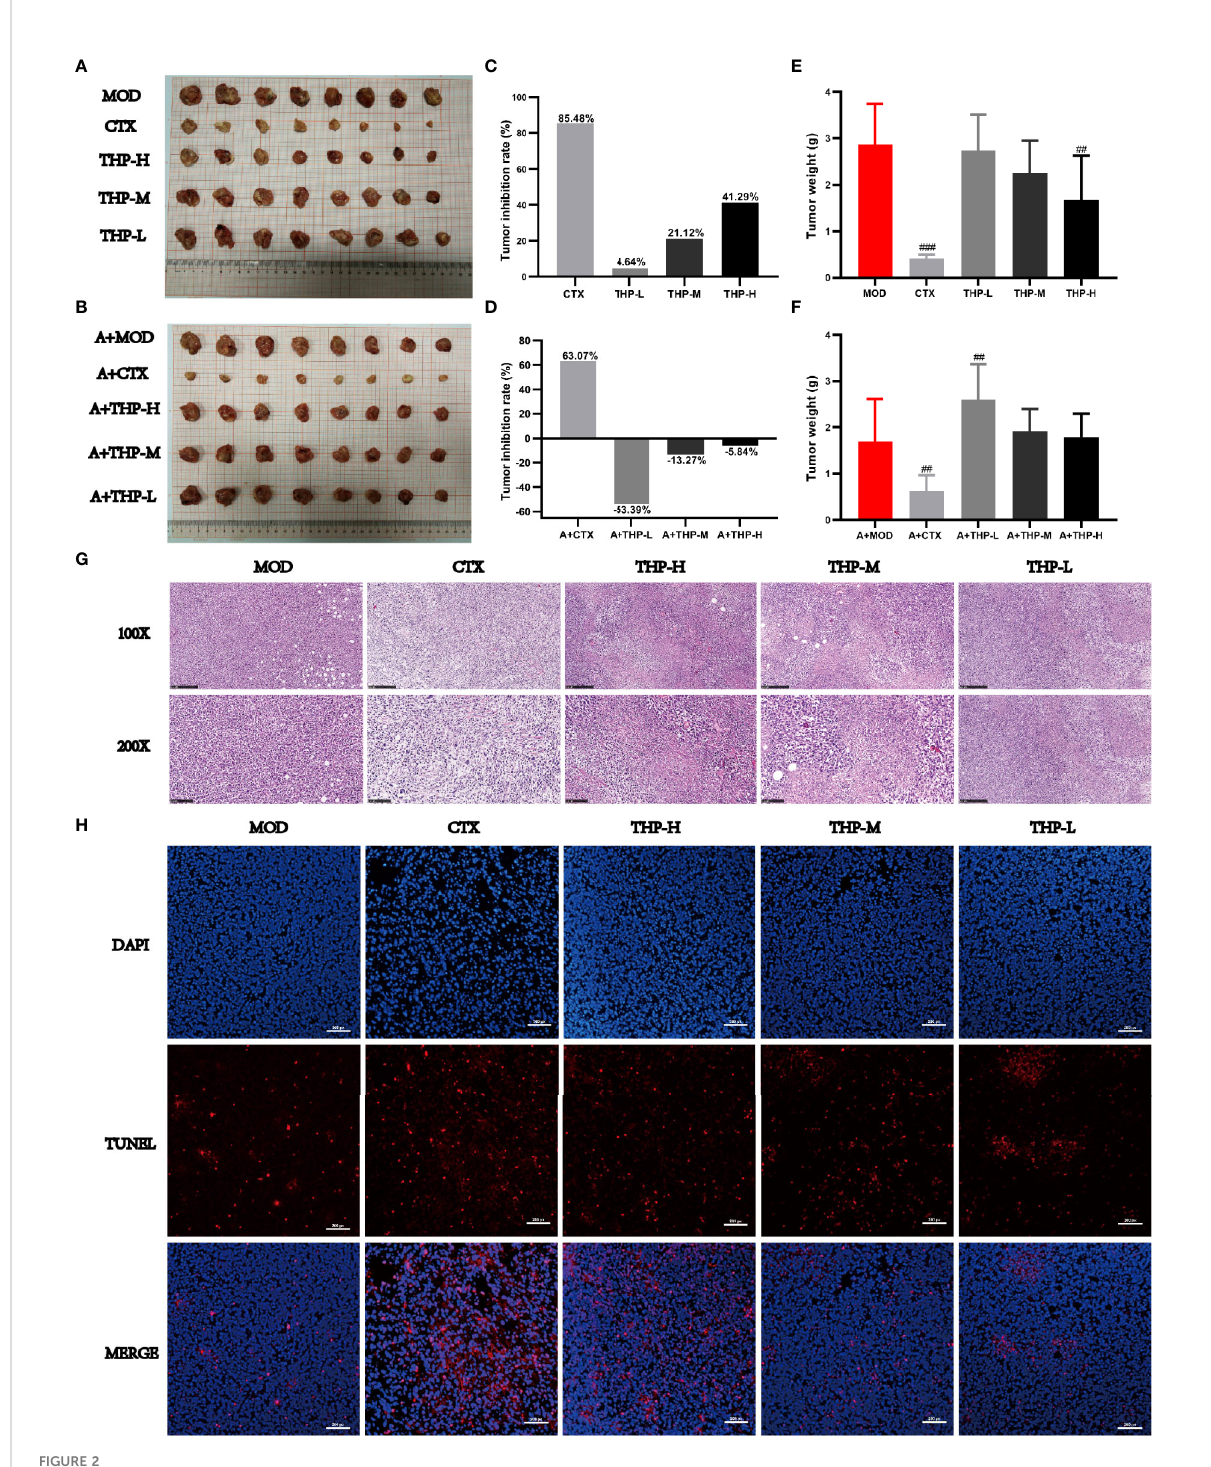
FIGURE 2 Effects of THP on tumor growth in Lewis tumor-bearing mice. (A, B) Photos of tumors. (C, D) Tumor inhibition rate. (E, F) Tumor index. (G) Histology of lung tumors. (H) Apoptosis of tumor cells. Each value is presented as the mean±SD. ## P<0.01, ### P<0.001 versus